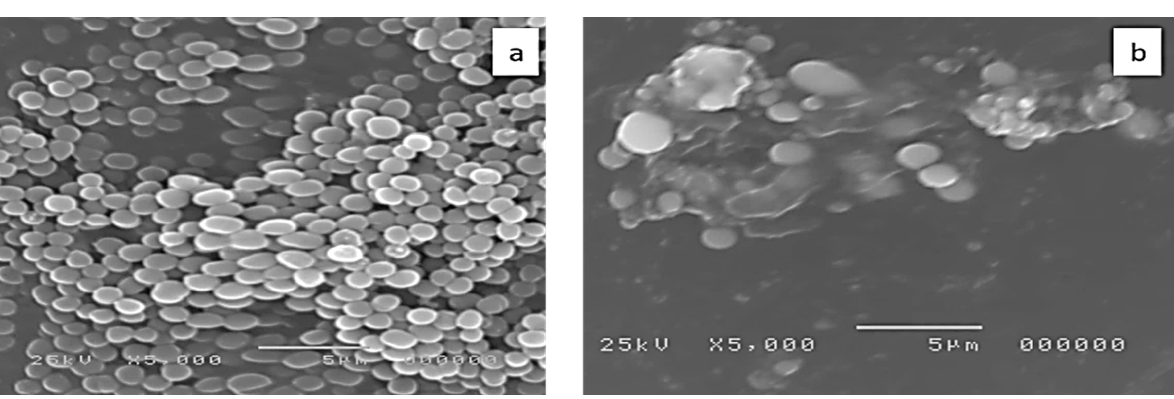
Figure 5. Scanning electron microscope image of a representative MRSA isolate ( a ) before treatment and ( b ) after treatment with the diethyl ether extract of C. macrocarpa leaves.